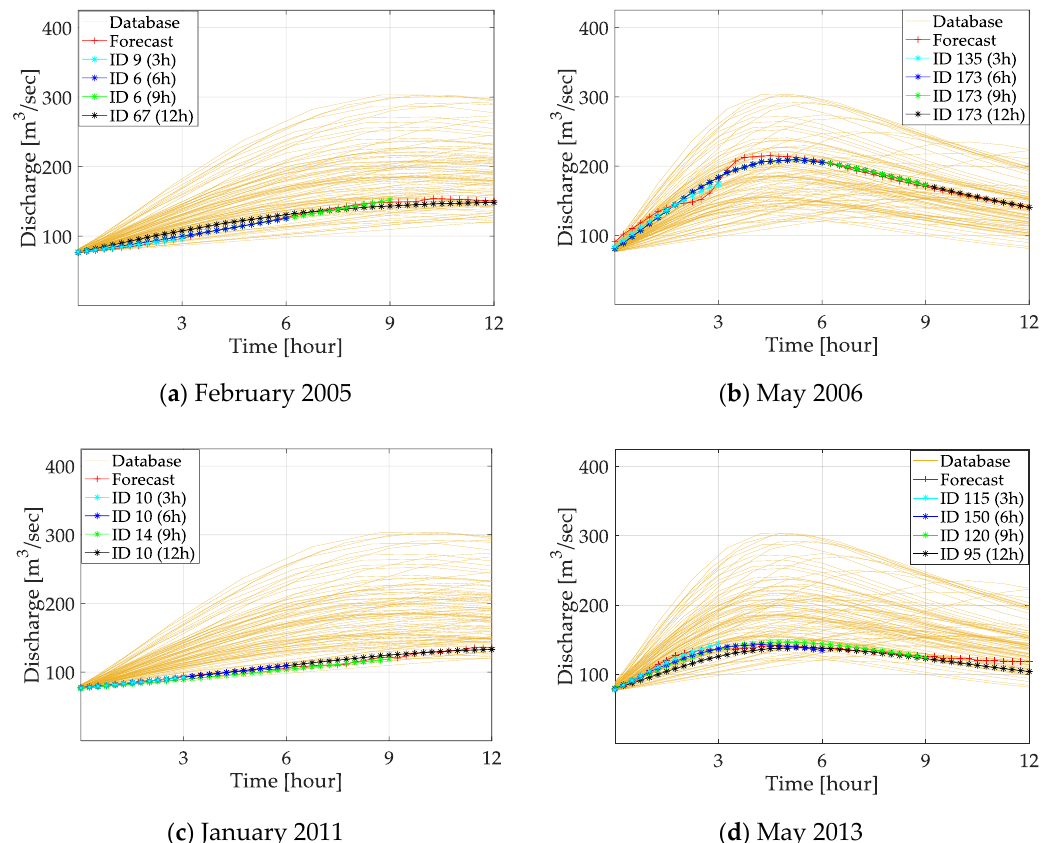
Figure 7. Comparison of discharge hydrographs at the virtual gauge: ( a , c ) advective events in February 2005 and January 2011, ( b , d ) convective events in May 2006 and May 2013.